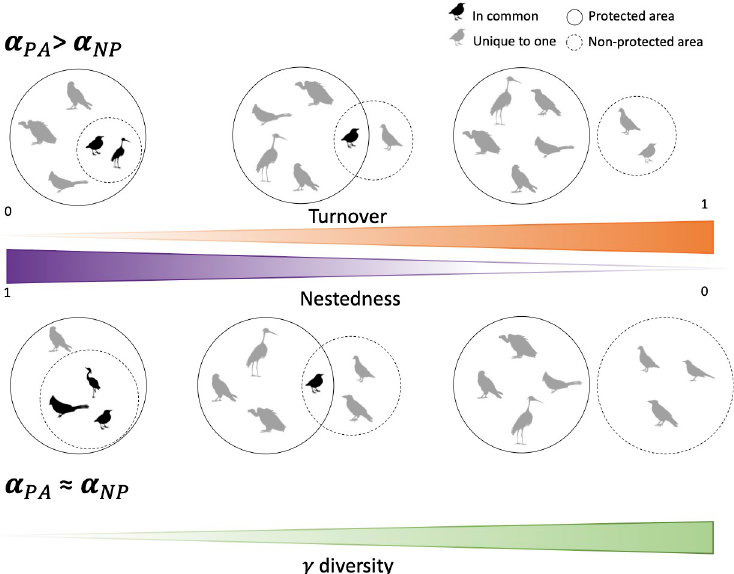
Fig 1. Illustration of species dissimilarity and ß-diversity partitioning between 2 components—species turnover and species nestedness with a theoretical comparison between a protected and a non-protected area sharing some species. This hypothetical example considers only 2 levels of protection and 2 levels of difference in species richness (circle area). On the left species occurring in the non-protected area are also present in the protected area while the opposite is not true, so the poorer area hosts only a subset of species which is nested in the species composition of the richer area. On the right, species turnover is maximal, with 3 species unique to each protection level and no species in common to both. Increase of species turnover induces a mechanical increase in γ -diversity. At the center, both patterns are present, some species occur in both the non-protected and the protected area (nestedness), but some species are unique to each protection level (turnover). Icons were extracted from https://www.publicdomainpictures.net/and are under the Public Domain Dedication 1.0